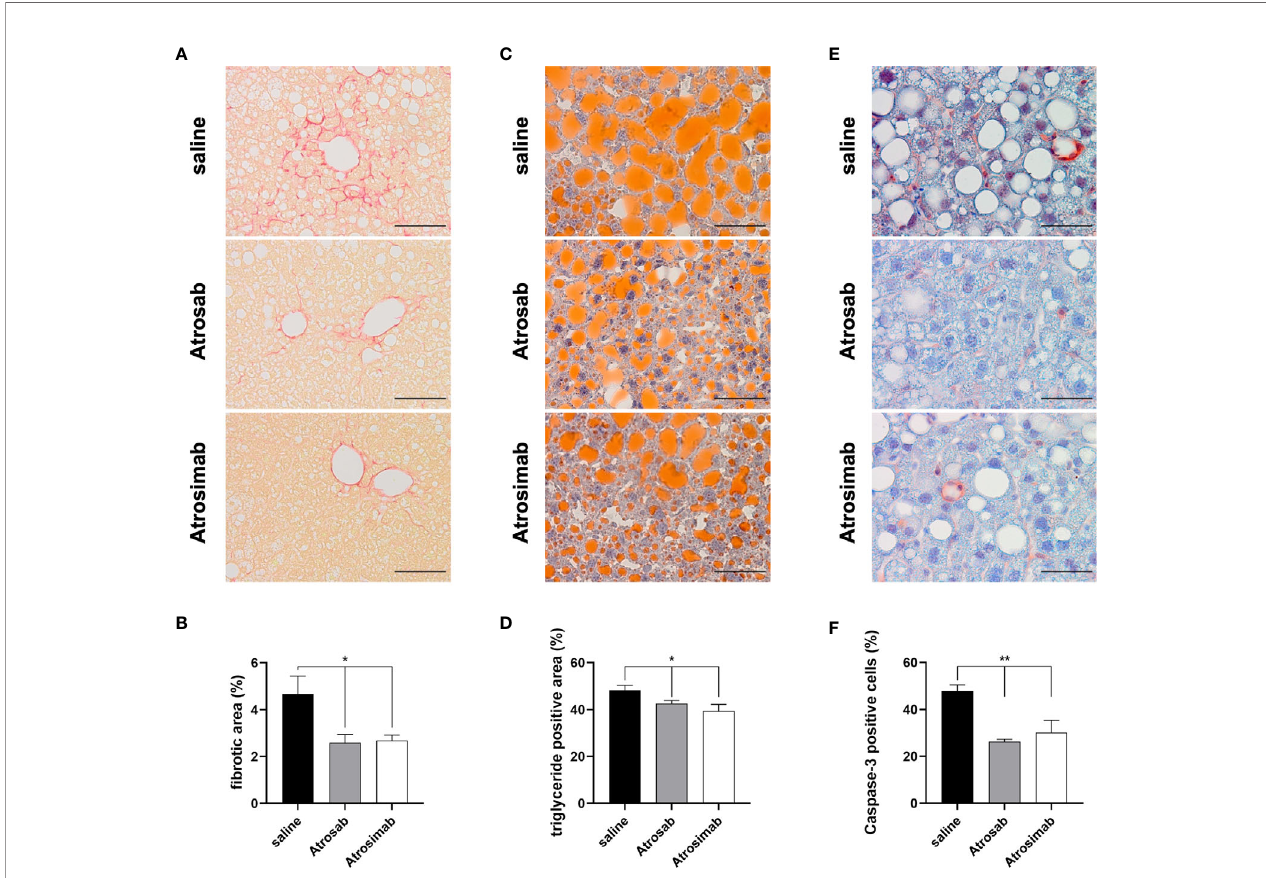
FIGURE 6 | Atrosimab alleviated fi brosis, steatosis and liver injury in a model of NAFLD. huTNFR1-k/i mice were fed a high-fat diet for 21 weeks and then treated with saline, Atrosimab and Atrosab for 8 weeks. Liver pathology was analyzed by quantifying (A, B) liver fi brosis, (C, D) steatosis and (E, F) liver injury. (A, B) Liver fi brosis was quanti fi ed using Sirius Red staining, (C, D) liver steatosis using Oil Red O staining to identify triglyceride content and (E, F) liver injury by detection of caspase-3 activity. Shown are representative pictures (A, C, E) and quanti fi cation of the histological analyses (B, D, F). a: scale bars = 100 µm, c,e: scale bars = 50 µm. Mean ± SEM, (B) : n=9 saline, n=8 Atrosab, n=7 Atrosimab; (D) : n=9 saline, n=6 Atrosab, n=5 Atrosimab, (F) : n=5 each: *p < 0.05, **p <